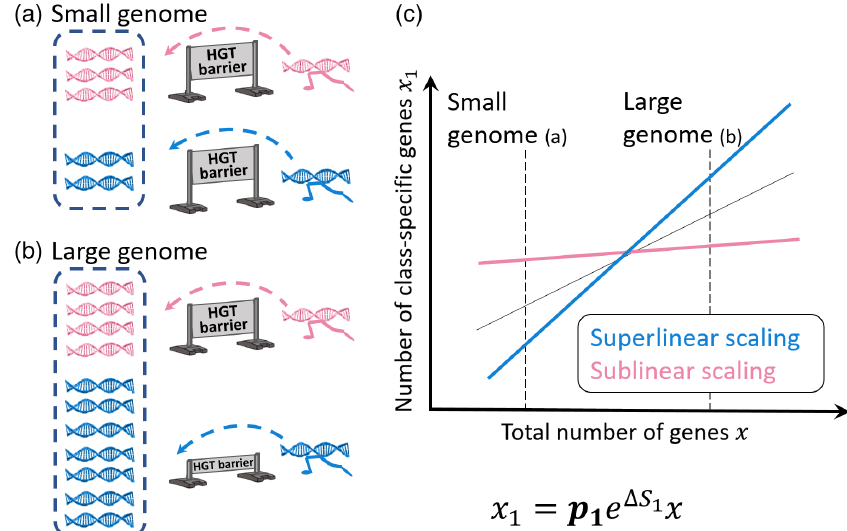
FIG. 2. Horizontal gene transfer barrier determines the scaling of class-specific genes. The gene-class-specific HGT barrier is high in small genomes (a) but substantially lower in large genomes (b). The dependence of the HGT barrier height on the genome size determines the scaling of the number of genes in each functional class ( x 1 ) with the total number of genes x (c). For functional classes with a weak dependence of the HGT barrier height on the genome size (e.g., genes for translation system components), the scaling is sublinear. In contrast, for those classes that show a strong dependence such that the HGT barrier is substantially lowered in larger genomes, the scaling is superlinear (e.g., genes for transcription factors). This figure shows schematically how the HGT barrier determines that scaling. Under our model, the class-specific HGT barrier is reflected by the genome plasticity p 1